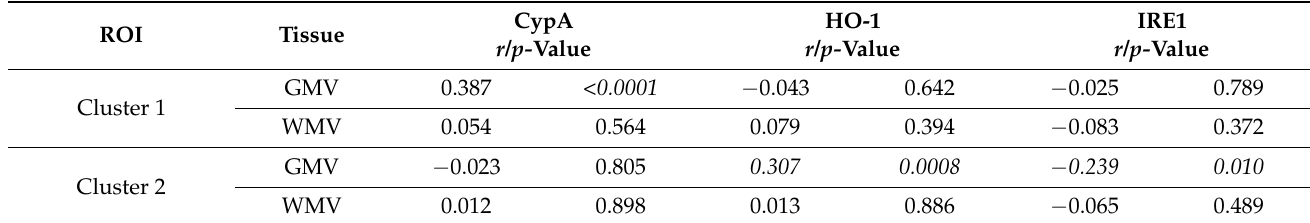
Figure 4. Pearson correlation analyses between the three blood-based biomarkers and brain tissue volumes in all par- ticipants and in subgroups. GMV, gray matter volume; WMV, white matter volume; cyclophilin A, CyPA; HO-1, heme oxygenase-1; IRE1, inositol-requiring enzyme 1; CN, cognitive normal; MCI, amnestic mild cognitive impairment; AD, Alzheimer’s disease. Table 3. Partial correlation analyses between brain tissue volumes and levels of the three plasma biomarkers after adjusting for age of all participants at each region of interest